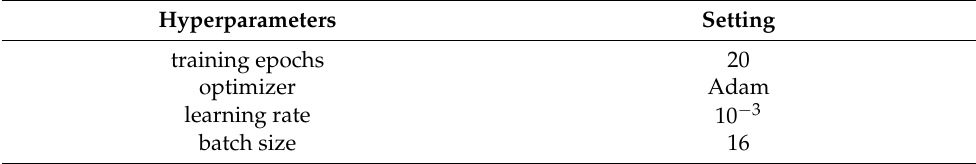
Table 7. The hyperparameters used for multimodal